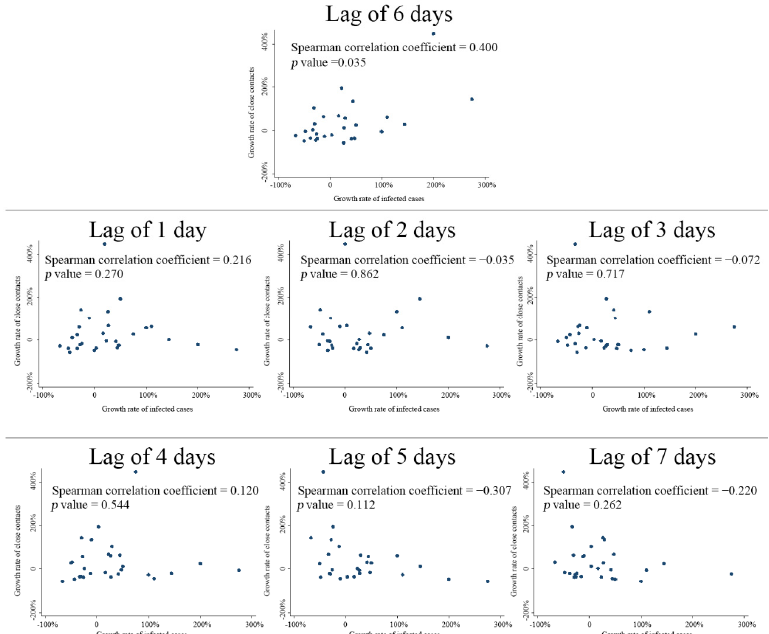
Figure 4. Spearman’s correlation coefficient between the growth rate of daily close contacts (before lockdown) and infected cases by different lag time number of daily close contacts and the number of daily infected cases, by different lag days.